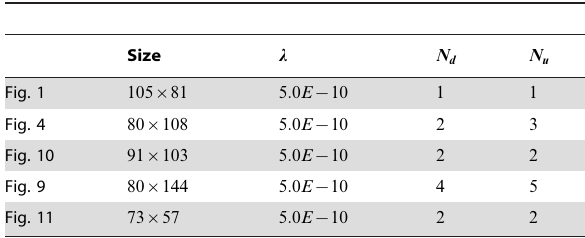
Table 1. Conditions of experiment N u is the number of ROIs and N d is the number of iteration.